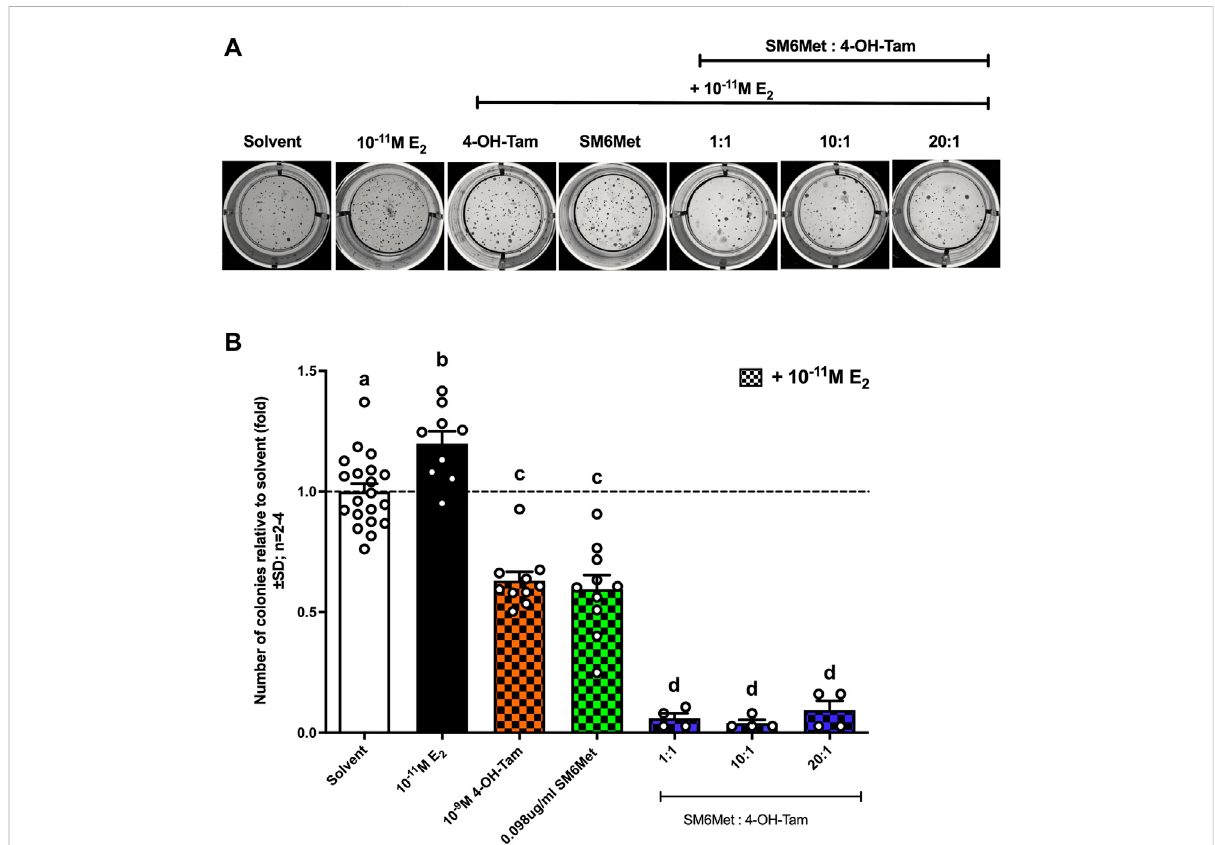
FIGURE 6 AllcombinationsofSM6Metwith4-OH-TamshowedgreaterinhibitionofcolonyformationthanSM6Metand4-OH-Tamontheirown.MCF7- BUS cells were suspended in 0.6% agarose and added onto the bottom 1% agarose layer. The cells were treated weekly with 4-OH-Tam and SM6Metaloneorincombination(1:1,10:1and20:1),allinthepresenceof10 − 11 ME 2 forthedurationof21 days. (A) Representativeimagesofcolonies when induced with compound or extract in the presence of 10 − 11 M E 2 were taken on day 21 after fi rst treatment. (B) The number of colonies formed were counted using ImageJ software and data represented as fold relative to the average results from the three negative solvent controls including (1) treatment medium, (2) 0.1% (v/v) EtOH in treatment medium and (3) 0.025% (v/v) DMSO in treatment medium. The dotted line through thebarsrepresentsthesolvent,whichwassettoone.Average±SDisofatleasttwoindependentbiologicalexperimentsdoneintriplicate.Statistical analysis was performed using One-way ANOVA with Tukey ’ s multiple comparisons test as post-test, where different letters indicate statistically signi fi cant differences at p < 0.05. Bars with common letters are not signi fi cantly